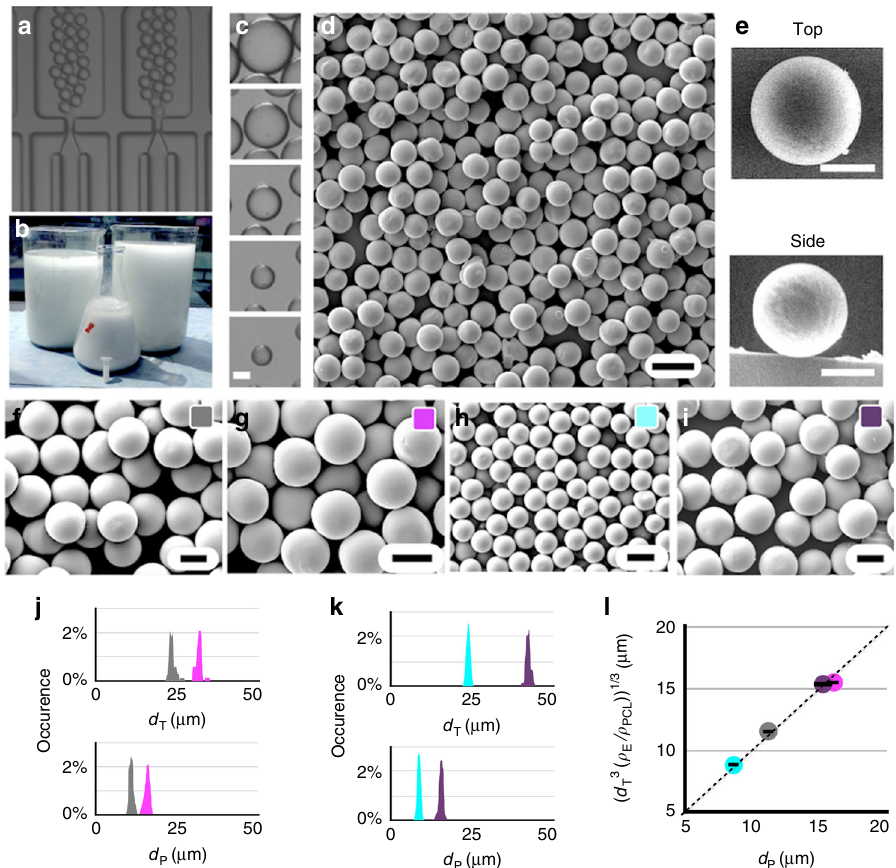
Fig. 5 High-throughput production of polycaprolactone microparticles. a Optical image of droplet generators producing monodisperse emulsion templates. The dispersed phase Φ d is 133gL − 1 of polycaprolactone (PCL) in dichloromethane (DCM), and continuous phase Φ c is 2wt% of polyvinyl alcohol (PVA) in water. b Emulsion of 8.76L could be generated in 75min. c . Evaporation of dichloromethane from emulsion templates as a function of time. Scale bar: 10 µ m. d An SEM micrograph of PCL microparticles, produced at 277gh − 1 . Scale bar: 20 µ m. e Top and side view of a single PCL microparticle. Scale bar: 10 µ m. f – i SEM micrographs of PCL microparticles generated with particle diameter d p using a template diameter d T. Scale bar: 10 µ m. Using 133gL − 1 PCL, we generated particles: f d P = 11.2 µ m (CV = 4.4%), d T = 23.2 µ m (CV = 2.5%) at 277gh − 1 and g d P = 16.1 µ m (CV = 4.4%), d T = 35.9 µ m (CV = 1.4%) at 109gh − 1 . Using 53.2gL − 1 PCL, we generated particles: h d P = 8.4 µ m (CV = 4.0%), d T = 24.5 µ m (CV = 2.4%) at 76.8gh − 1 and ( i ) d P = 15.2 µ m (CV = 3.6%), d T = 42.7 µ